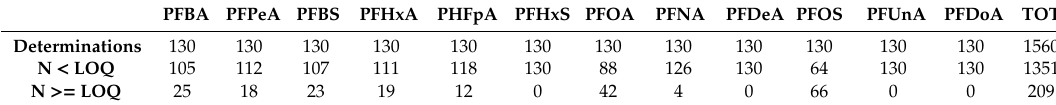
Table 7. Perfluorinated distribution in ground water.